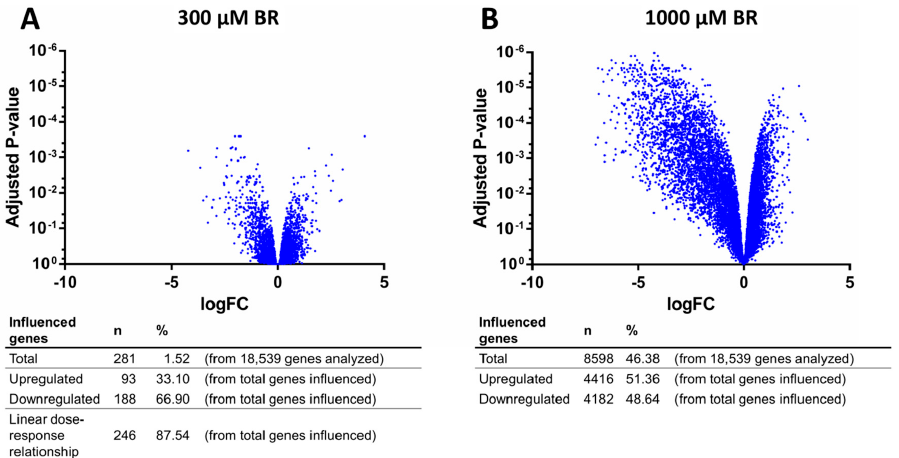
Figure 8. Volcano plot representing the differential expression of all measured genes after exposure to diclofenac: the transcriptional effects of treatment in 300 µM bioreactors (300 µM BR) ( A ) or 1000 µM bioreactors (1000 µM BR) ( B ). The x - and y -axes represent the magnitude and the significance, respectively, of the transcriptional effect per gene (control bioreactors (control BR) ( n = 4), 300 µM BR Table 1. Gene Ontology (GO) gene sets most strongly affected upon treatment with a low dose of diclofenac (300 µM bioreactors). Rank GO ID Size p -Value Description Parent Gene Ontology Biological